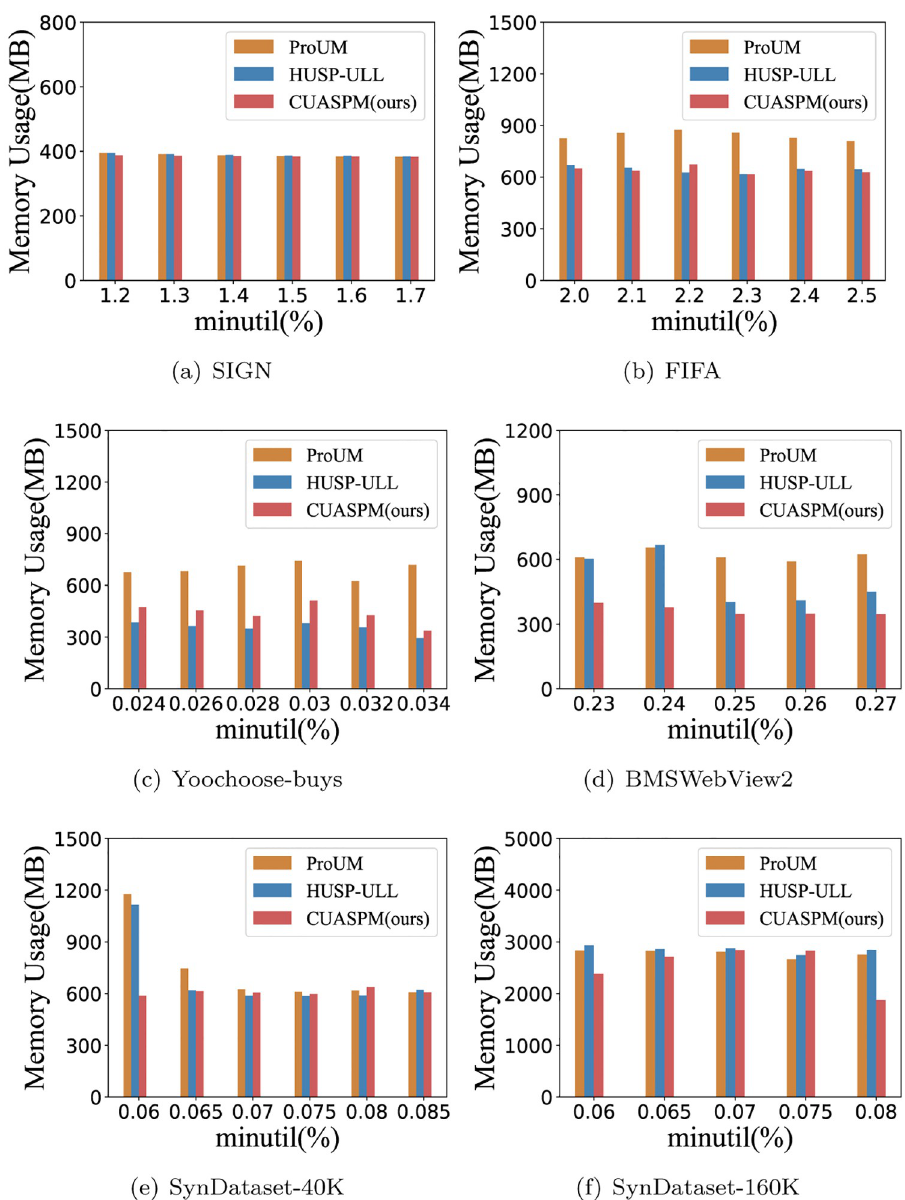
Fig 5. Memory usage under the various minutil thresholds. (a) SIGN, (b) FIFA, (c) Yoochoose-buys, (d) BMSWebView2, (e) SynDataset-40K, and (f) SynDataset-160K.